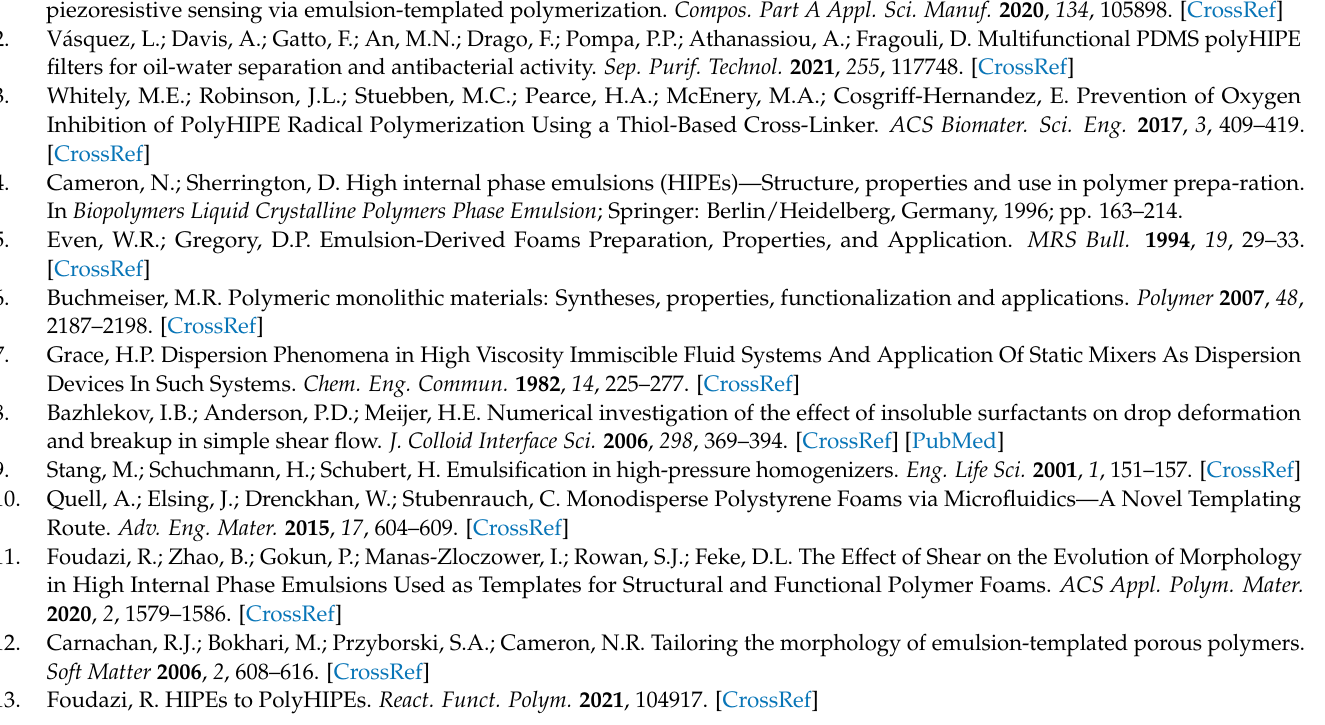
figure preparation, P.D., E.C.-H., R.F., J.S., K.S., and J.C.; writing—original draft preparation,